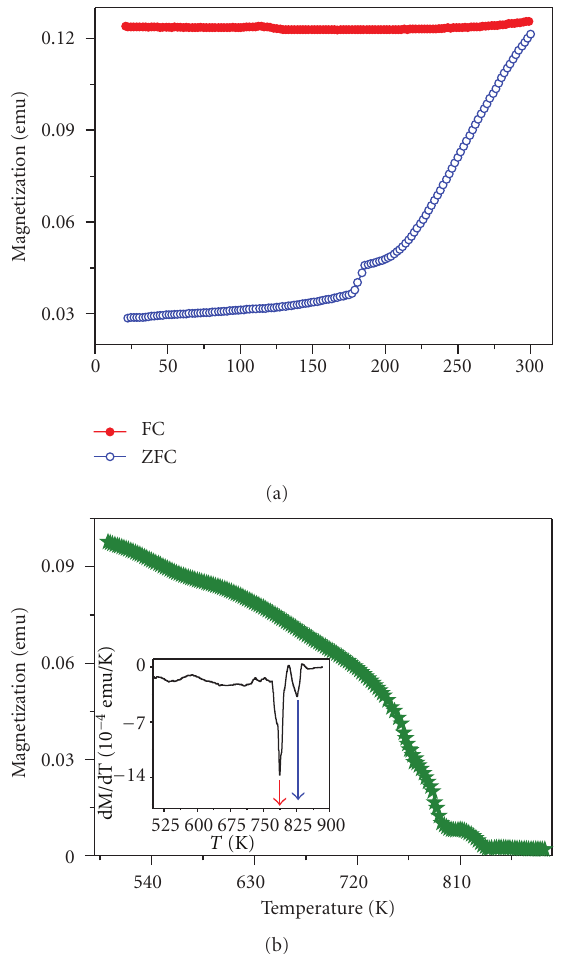
Figure 4: Temperature dependent magnetization curves measured at an applied field of 200 Oe (a) at low temperatures between 20 and 300K under ZFC and FC conditions and (b) at high temperatures for as-prepared CoFe 2 O 4 –Fe 2 O 3 magnetic nanoparticles. Inset: Plot of thermal derivative of magnetization with temperature.